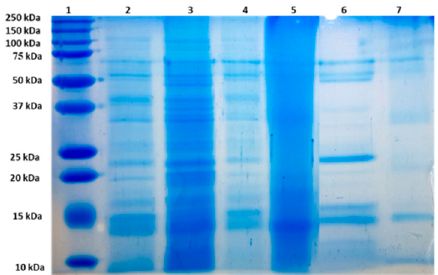
Figure 1. SDS-PAGE (4.5%–15%) profile of the black rice flour proteins (lane 2), of F7 proteins and of albumin, glutelin, globulin and prolamin extracts (lanes 3–7). Lane 1- Precision Plus Protein Dual Extra.